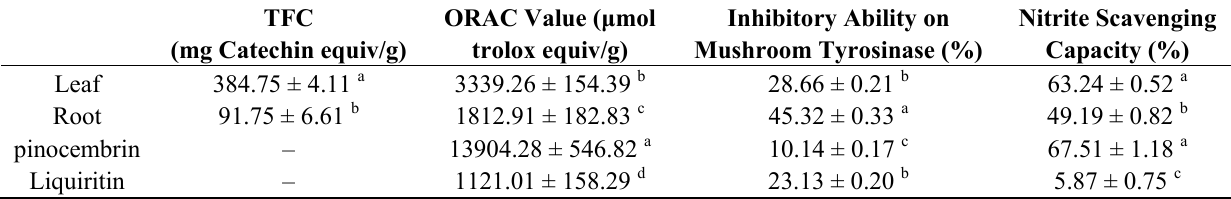
Table 1. The total flavonoid content, nitrite scavenging capacity, oxygen radical absorbance capacity and inhibitory effect on mushroom tyrosinase of tested